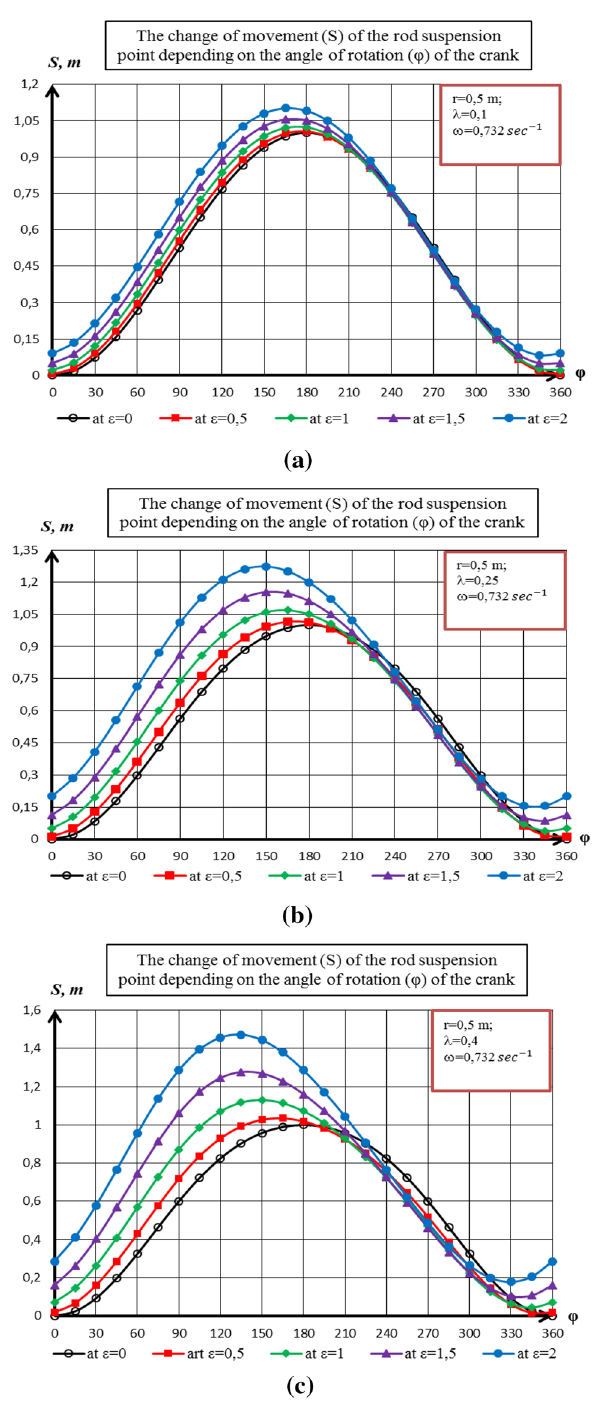
Fig. 1 The change of movement ( S ) of the rod suspension point depending on the angle of rotation ( 𝜑 ) of the